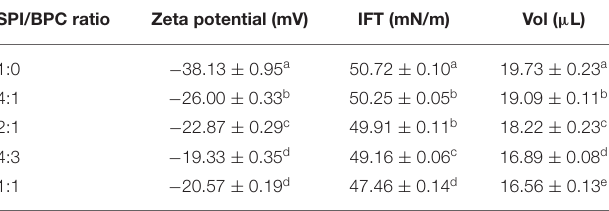
TABLE 1 | Zeta potential and interfacial tension of SPI, BPC, and different SPI/BPC ratios at various mass ratios.